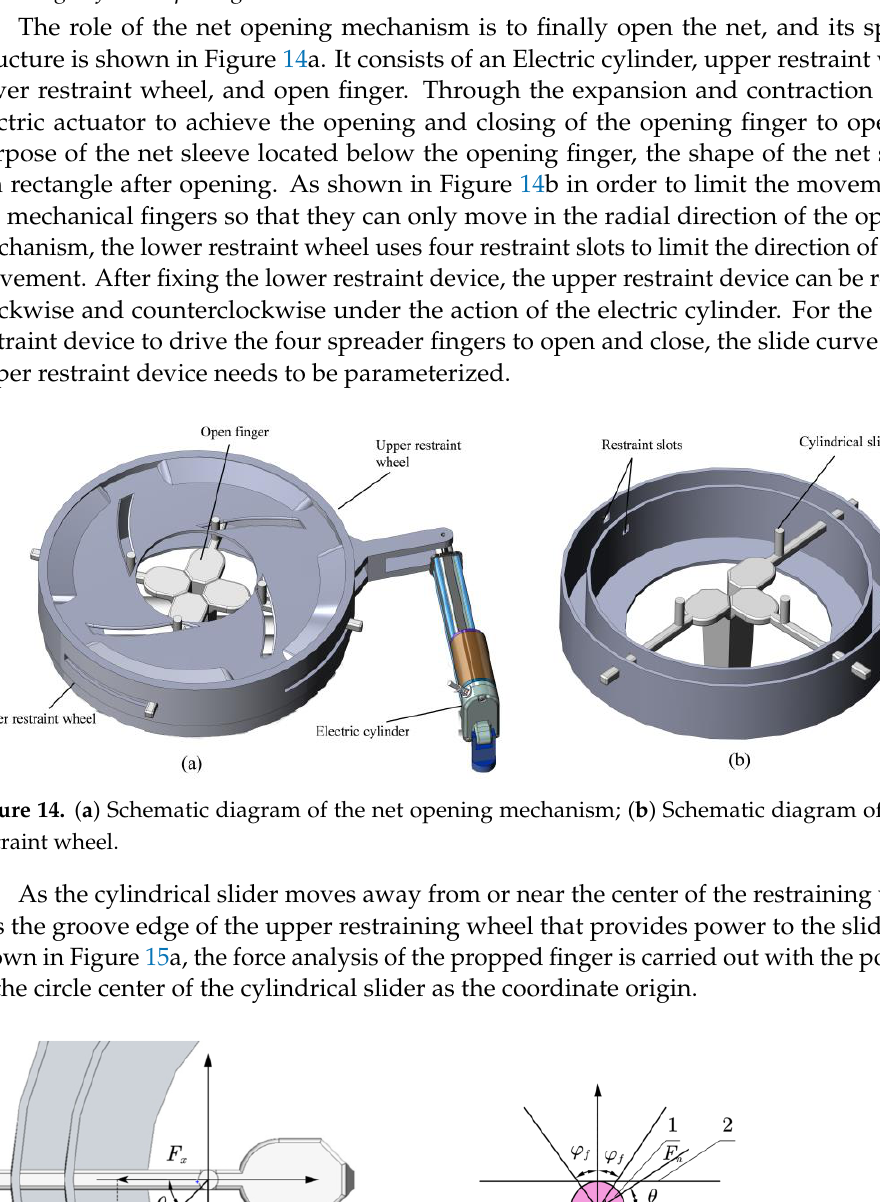
Figure 15. ( a ) Finger mechanics analysis; ( b ) Self-locking phenomenon. Within the figure, F n represents the combined force of the slide on the finger; F x represents the component force of F n in the direction of finger movement; F y stands for frictional resistance; θ represents the angle between the combined force and the direction of motion.